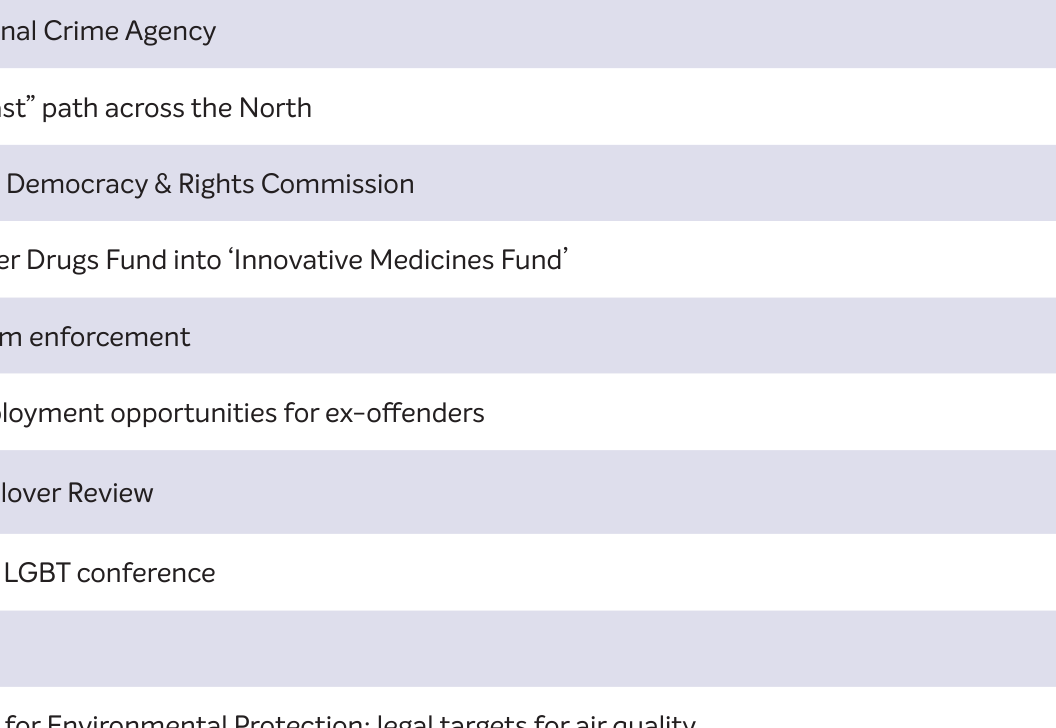
Table 2: Commitments funded from existing departmental budget allocations Bolster National Crime